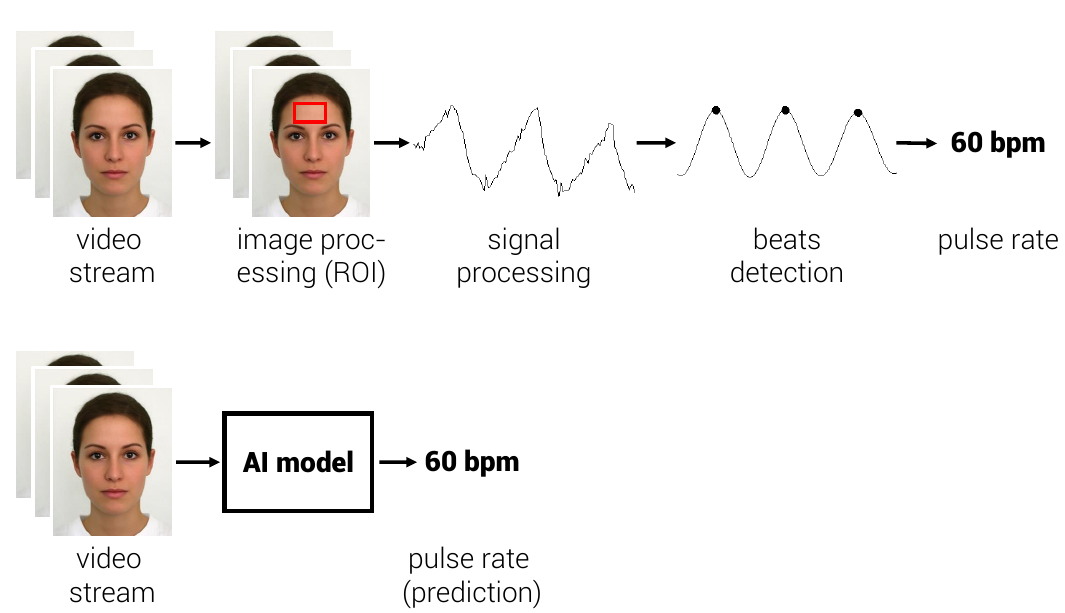
Figure 1. (top) Conventional approach: image processing operations are applied to the video stream to detect pixels or regions of interest (ROIs). The signal is traditionally computed using a spatial averaging operation over the ROI before being processed with spectral or temporal filters. Finally, biomedical parameters like pulse rate are estimated from this signal. (bottom) The approach we propose consists in training an artificial intelligence model using only synthetic data. The input corresponds to a video stream (image sequence). The model predicts a pulse rate for each video patch (25 × 25 pixels over 60 frames) and thus produces a map of predictions instead of a single